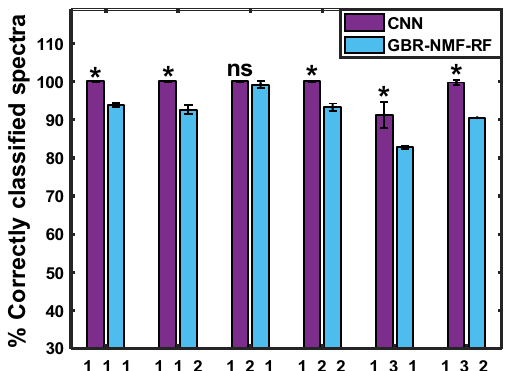
Figure 9. Percentage of correctly classified spectra (test accuracy) corresponding to each Raman map of mouse 1 being removed from the training set (leave-one-map-out validation). CNN (violet) and GBR-NMF-RF (blue). Map labels given as mouse number_(section #)_(map #). *Represent significant difference between CNN and GBR-NMF-RF (p < 0.05), ns = not